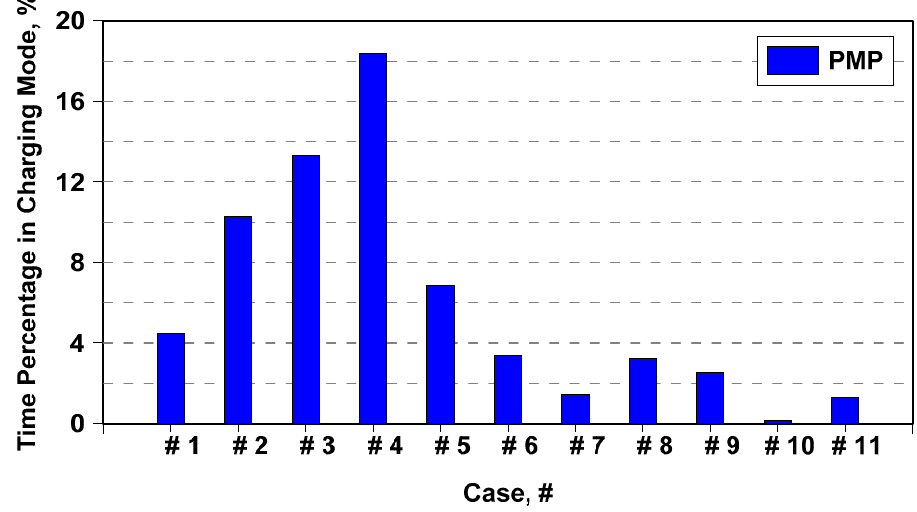
Figure 16. Time percentage in charging mode for PMP in the cases of Table